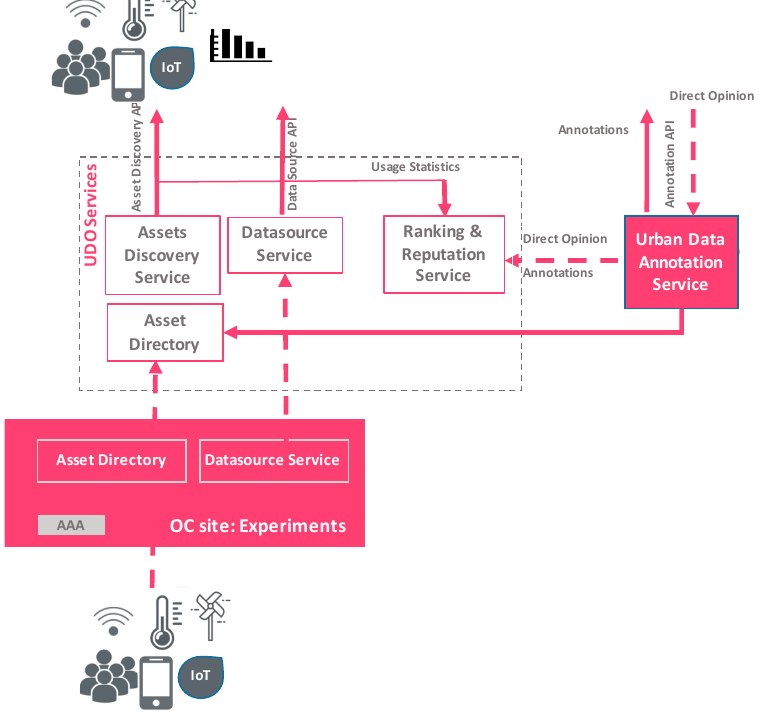
Figure 5. Urban Data Observatory architecture.